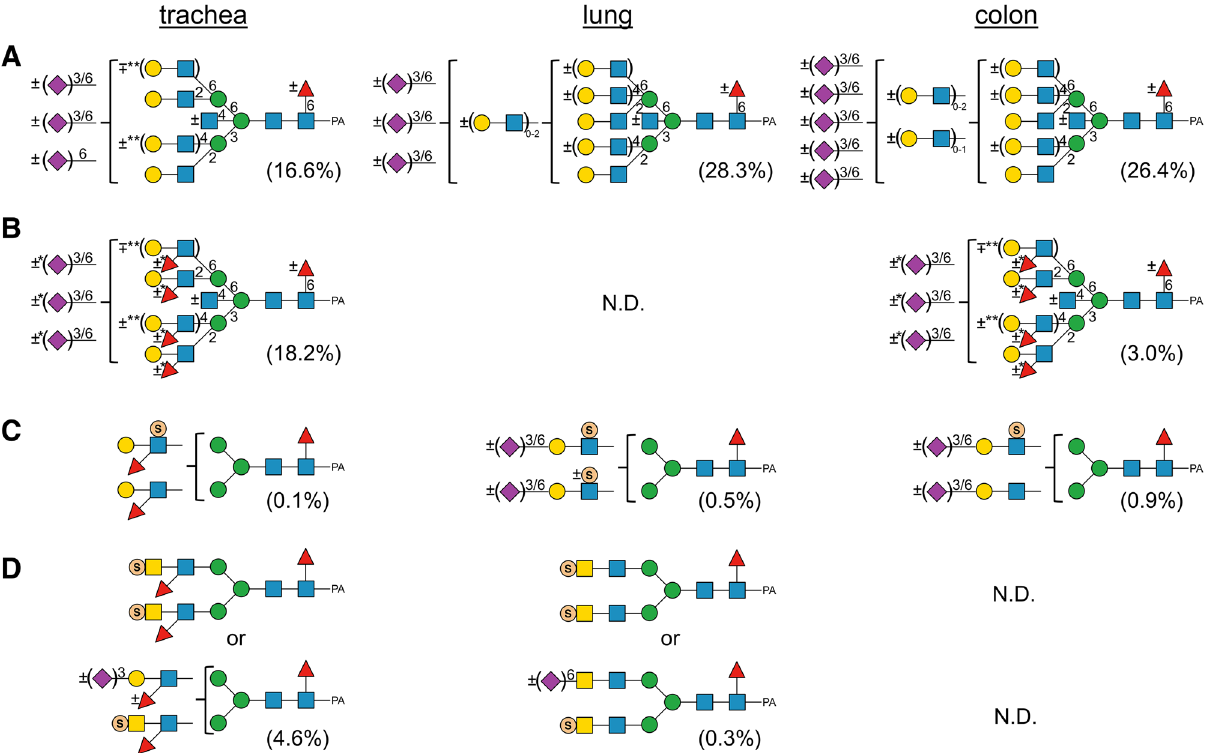
Figure 8. Comparison of the structural features of sialylated and/or sulfated complex-type PA- N -glycans from chicken trachea, lung, and colon. ( A ) Summary of the sialylated complex-type PA- N -glycans without branch fucosylation in the three tissues. Double asterisks (**) indicate that the 4-branch and the 6 ′ -branch do not exist simultaneously. ( B ) Summary of the sialylated complex-type PA- N -glycans with branch fucosylation in chicken trachea and colon. An asterisk (*) indicates that α2,6-sialylations are found only when GlcNAc residues on the same branches are non-fucosylated. ( C ) Summary of the complex-type PA- N -glycans with 6-sulfated (sialyl) LacNAc branches with or without branch fucosylation from the three tissues. ( D ) Summary of the complex-type PA- N -glycans with sulfated LacdiNAc branches with or without branch fucosylation from trachea and lung. Each value (%) is expressed relative to the total amount of PA- N -glycans (= 100%) in Supplementary Table